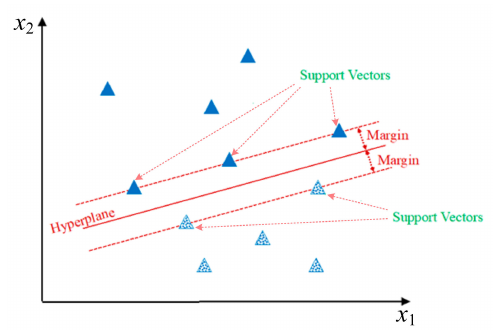
Figure 3. An example linearly separable problem and the hyperplane that separates the data